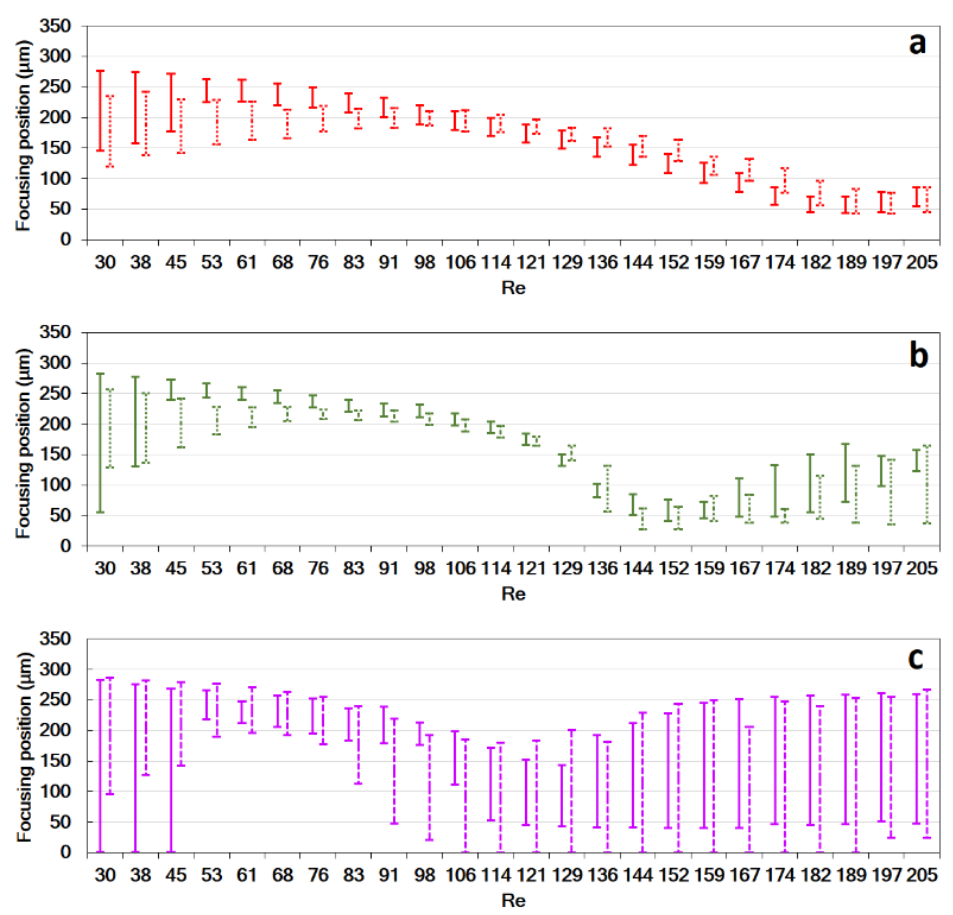
Figure 5. Focusing position against Reynolds numbers for microparticles of ( a ) 20 µm, ( b ) 15 µm, and ( c ) 10 µm diameter in the transition region of asymmetric (solid bars) and symmetric [63] (dashed bars) curvilinear microchannel, both having a curvature angle of 280°. Error bars indicate the width of the focusing streak.